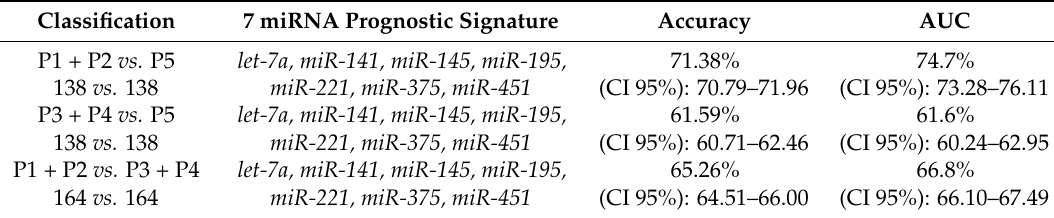
Table 4. Accuracy and Area Under the Curve (AUC) for the seven miRNA prognostic signatures. CI = confidence